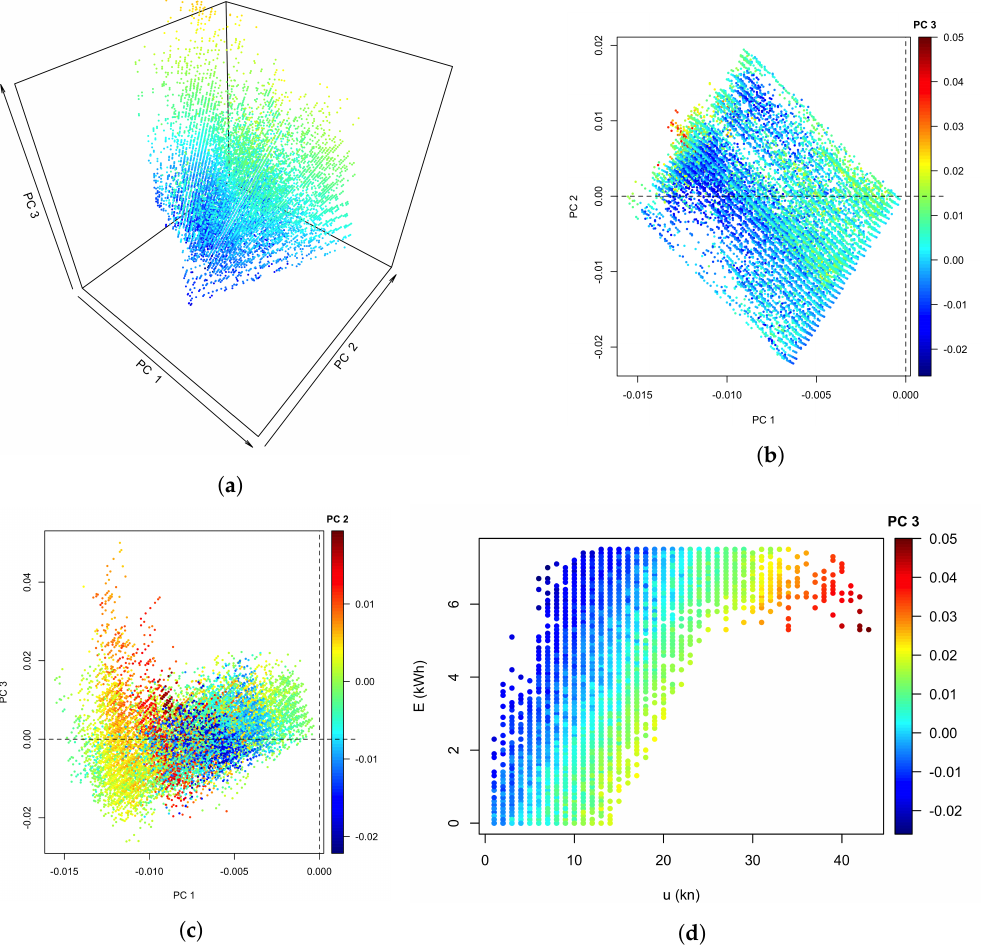
Figure 5. Principal components from training data: ( a ) 3D scatter plot, ( b ) projection onto the PC 1 - PC 2 plane with points colour-coded by PC 3 , ( c ) projection onto the PC 1 - PC 3 plane colour-coded by PC 2 , ( d ) empirical performance curve colour-coded by PC 3